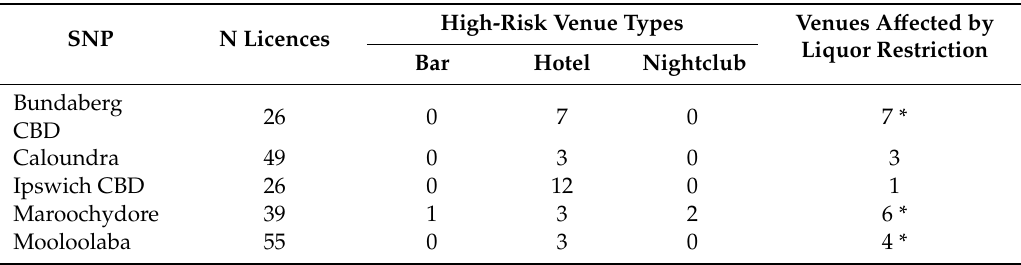
Table 1. Venue details for safe night precincts (SNPs) with closing times after 00:00 and not after 3:00 before July